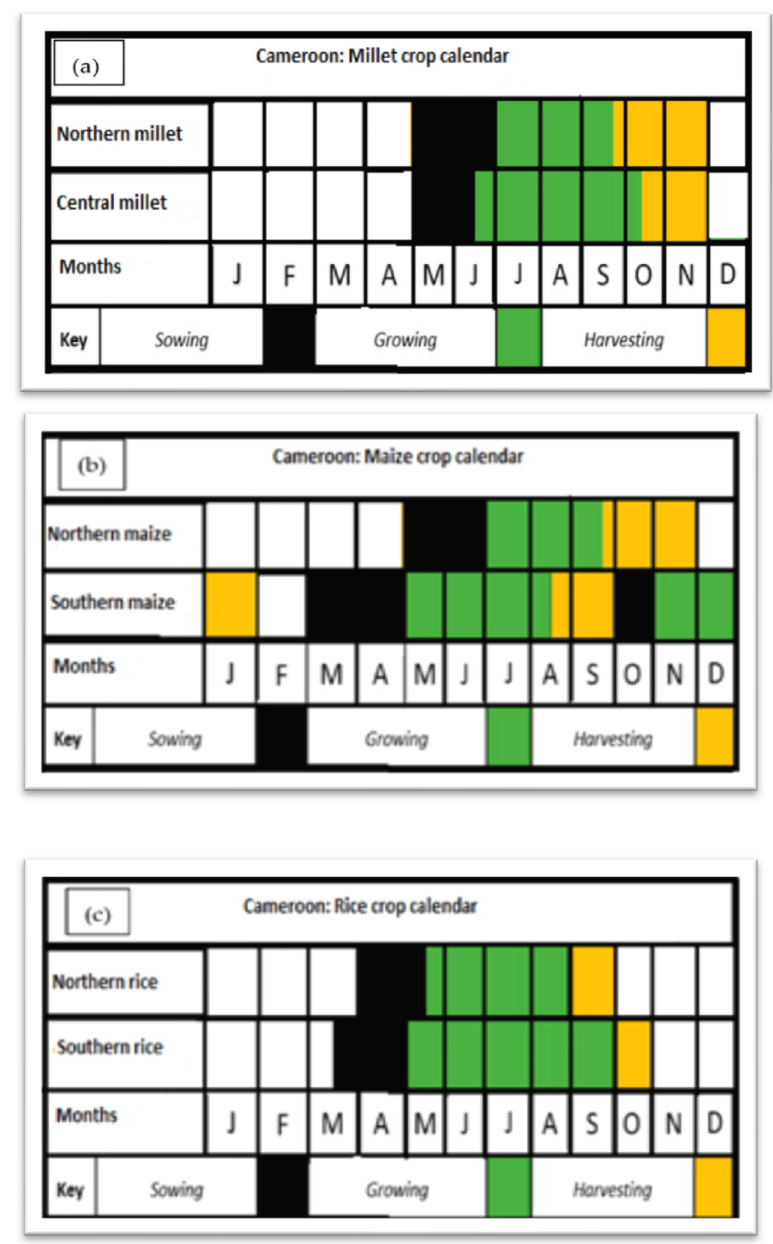
Figure 3. Growing Seasons for ( a ) Maize, ( b ) Millet and ( c ) Rice.